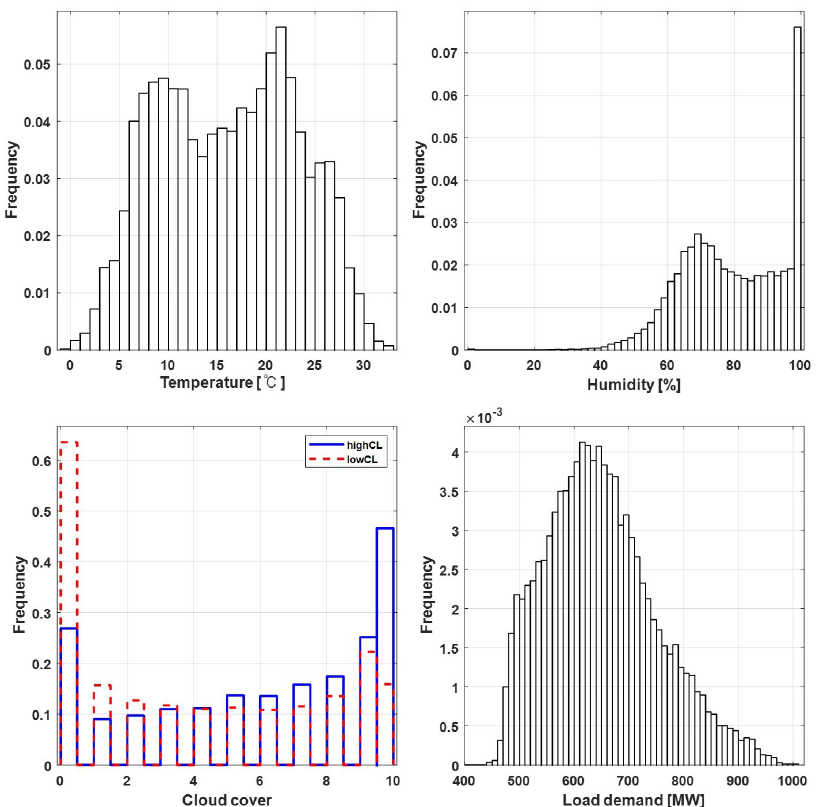
Figure 3. Atmospheric data and load demand data collected from Jeju Island (January 2019– December